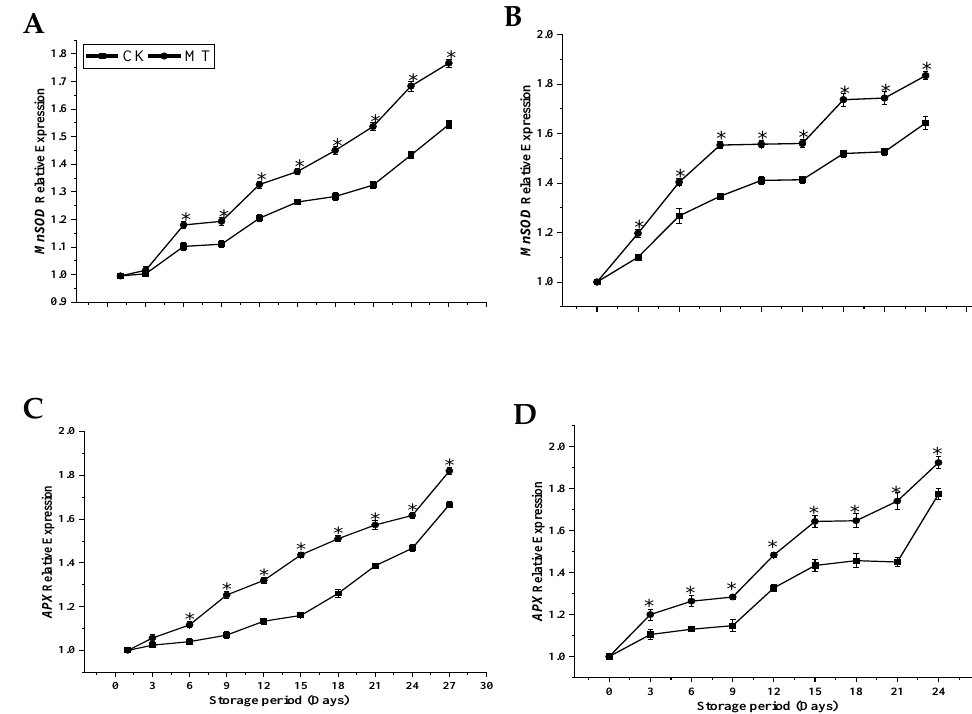
Figure 10. MnSOD relative gene expression ( A , B ) and APX relative gene expression ( C , D ) of ‘Guiqi’ ( A , C ) and ‘Tainong 1’ ( B , D ) fruits treated with 1000 µ mol L − 1 MT. Each value is the mean for three replicates, and vertical bars indicate the standard error (SE). Error bars with an asterisk (*) on the same storage period show a significant difference between the treatments ( p < 0.05).